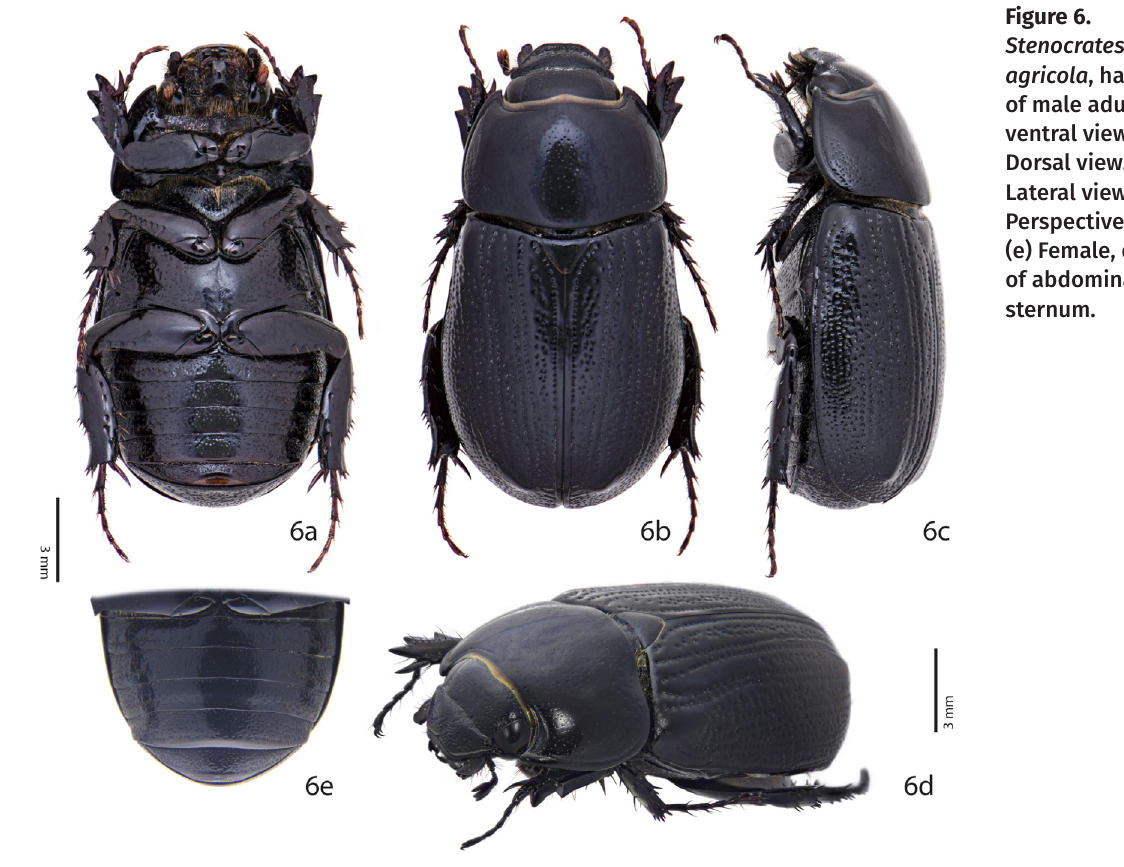
Figure 6. agricola , habitus of male adult: